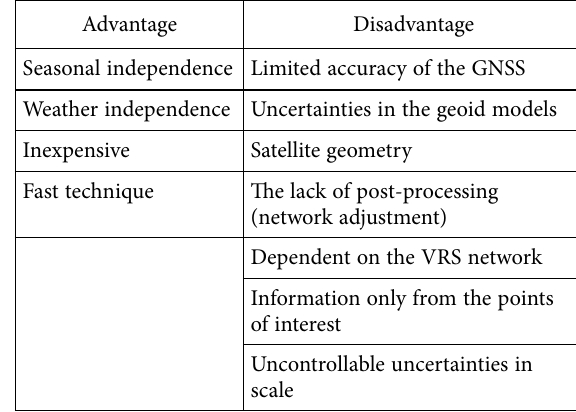
Table 1. Advantages and disadvantages related